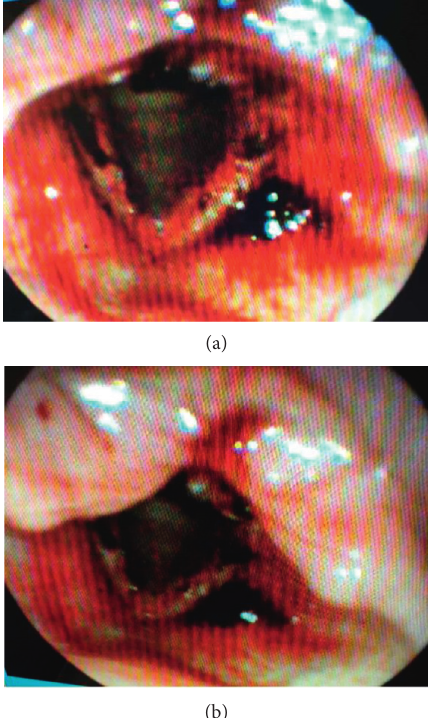
Figure 2: Petechiae of the supraglottis and false vocal folds; scabbing of the interarytenoid region, glottis, and